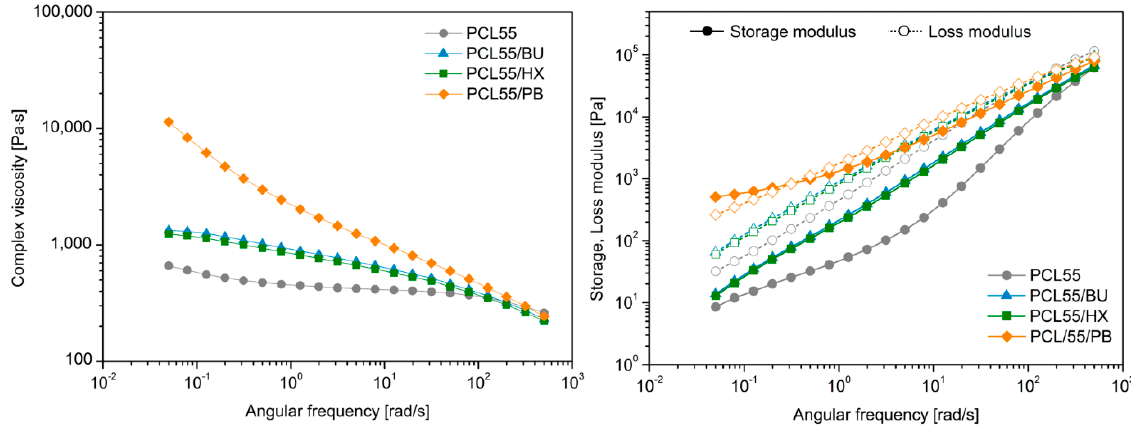
Figure 10. Complex viscosity, storage and loss modulus of unmodified PCL/PLA blends with weight ratio of 55/45 and modified by OP.